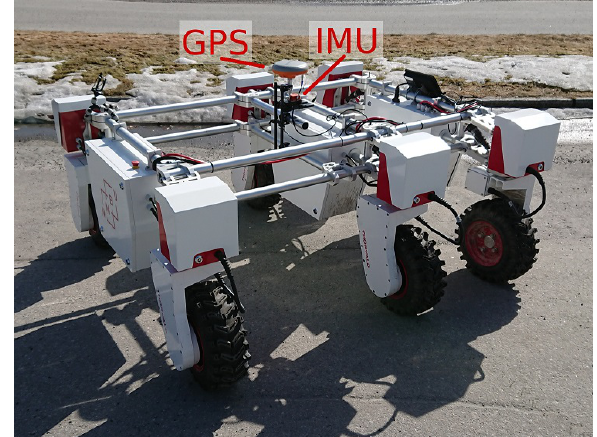
Figure 7: One of the robots that were used for testing the robot’s ability to estimate velocity from joint states. This robot has six-wheel drive and six- wheel